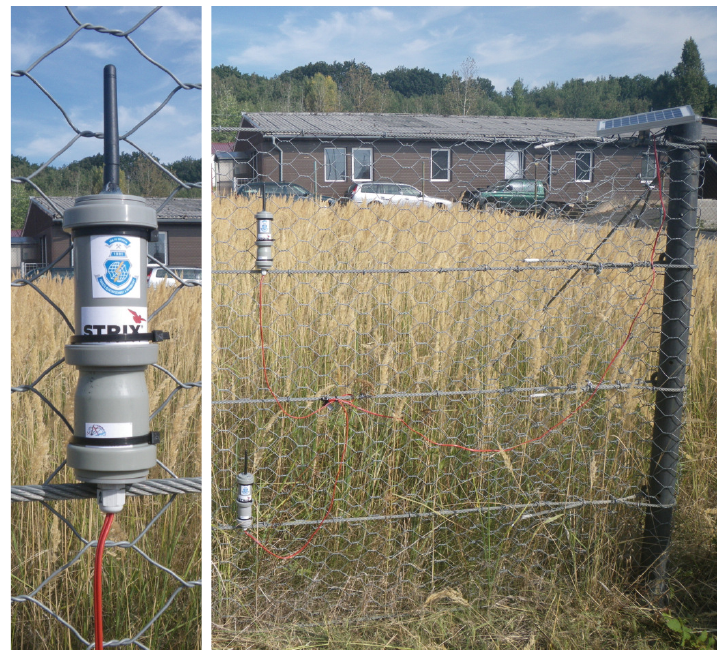
Figure 9. Detailed view of the accelerometer wireless sensor nodes in plastic tubes.